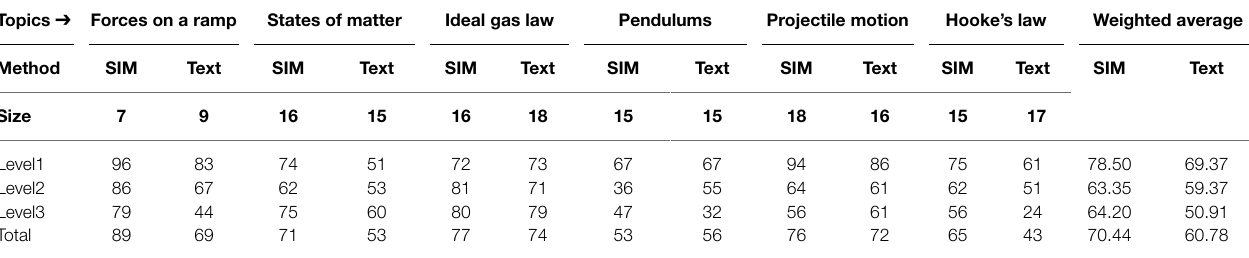
TABLE 11 | Comparing grades 8–11 general science and physics classes using SIM-based generative practices vs text-based illustration